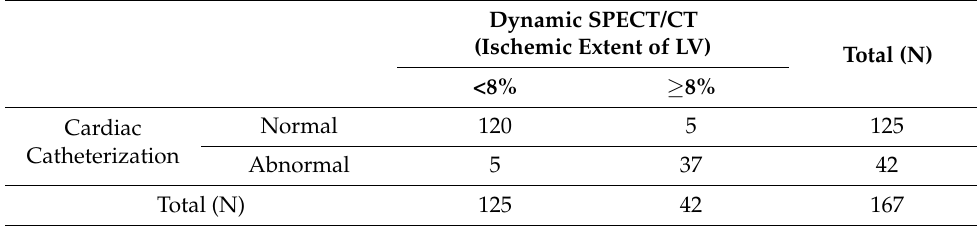
Table 4. Comparison of MBF and CFR between normal patients and CAD patients. Normal Group CAD Group p Value ( n = 125) ( n = 42) LV-CFR 2.6 ± 0.8 1.5 ± 0.4 <0.01 LV-stress flow